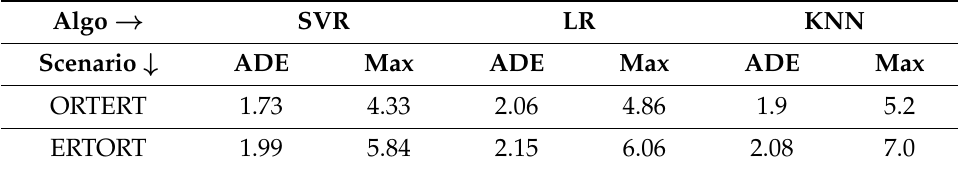
Table 9. ADE and maximum localization error at any TP for different scenarios